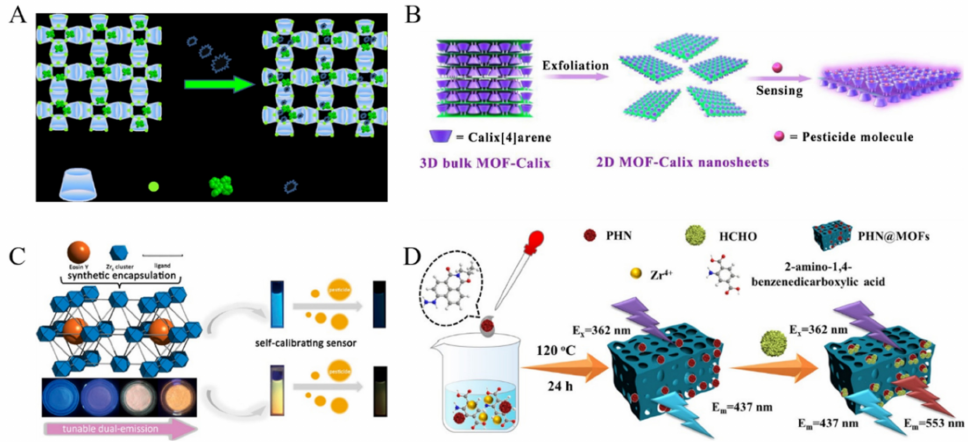
Figure 7. ( A ) Schematic illustration of the AIE-active MOFs for sensitive detection of explosives in liquid and solid phases. Reproduced with permission [115]. Copyright 2020, American